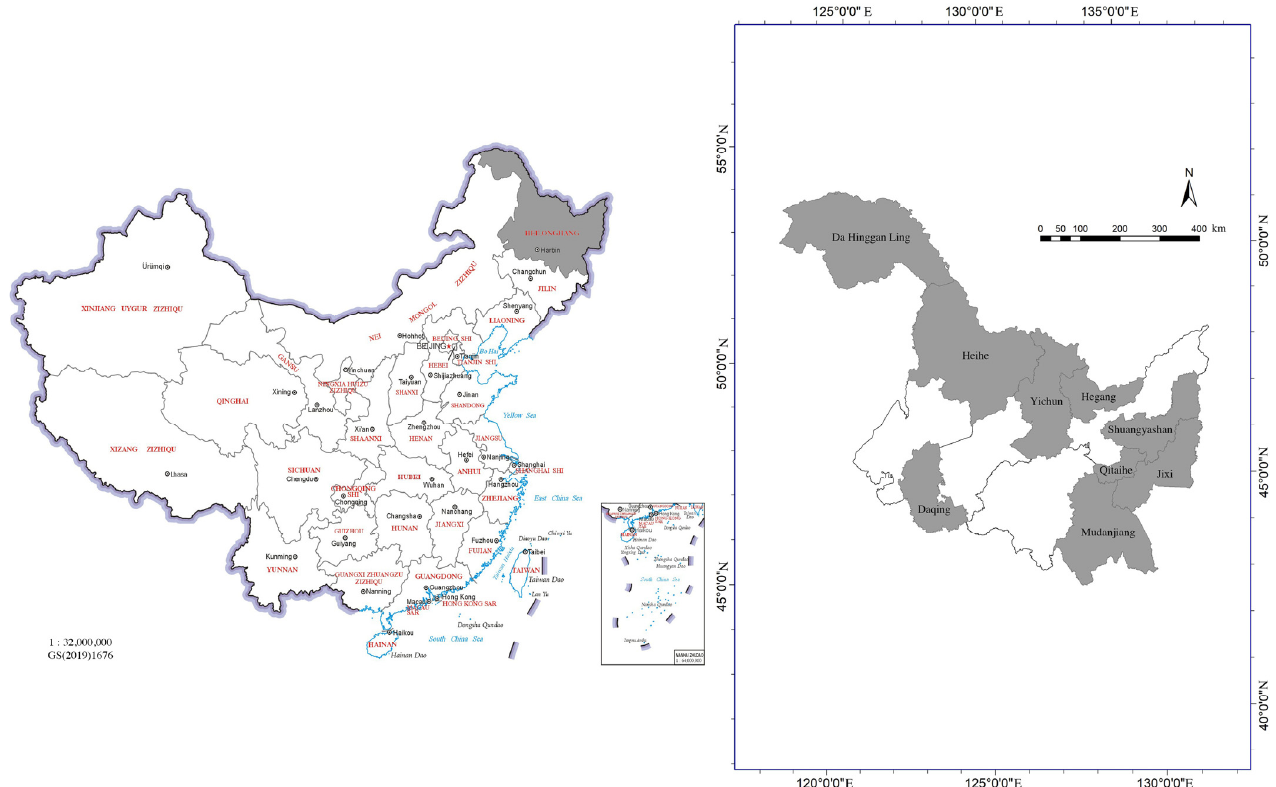
Figure 1. Location of RBCs in Heilongjiang Province, China.